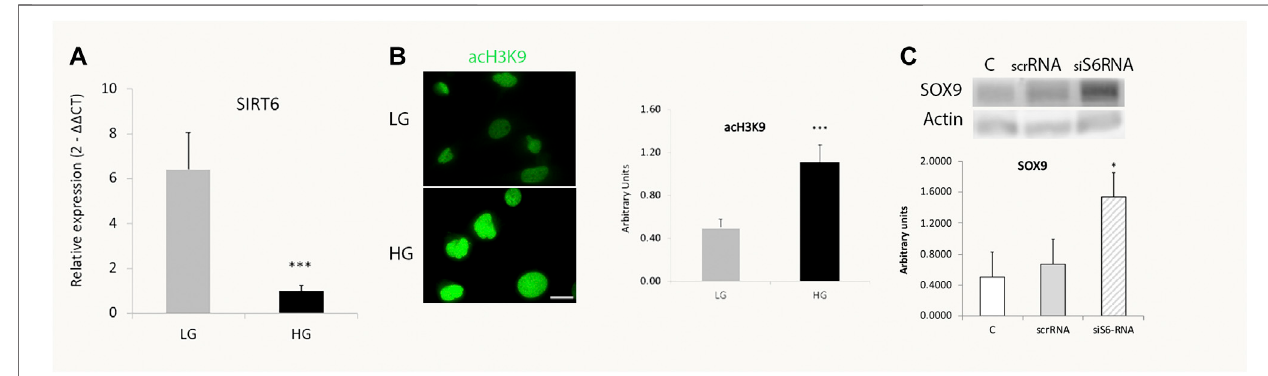
FIGURE 3 | SIRT6 levels decrease in high glucose treated cells. (A) qPCR analysis revealed a decrease in SIRT6 mRNA levels in MGs cultured with high glucose (HG, 25 mM) compared to low glucose (LG, 5 mM). (B) . Representative immuno fl uorescence shows the acetylation levels of SIRT6 substrate H3H9 (green) in MGs cultured under low glucose (LG, 5 mM) or high glucose (HG, 25 mM). Quanti fi cation was performed using the ImageJ program. Scale bar: 10 μ m. (C) Müller glia responsetoSIRT6silencing.SIRT6siRNAwastransientlytransfectedandthelevelsofSOX9weredeterminedbyWesternblot. β -actinwasusedfornormalization. Data are mean ± SE and images show a representative picture from three independent experiments. * p < 0.05, *** p < 0.001.